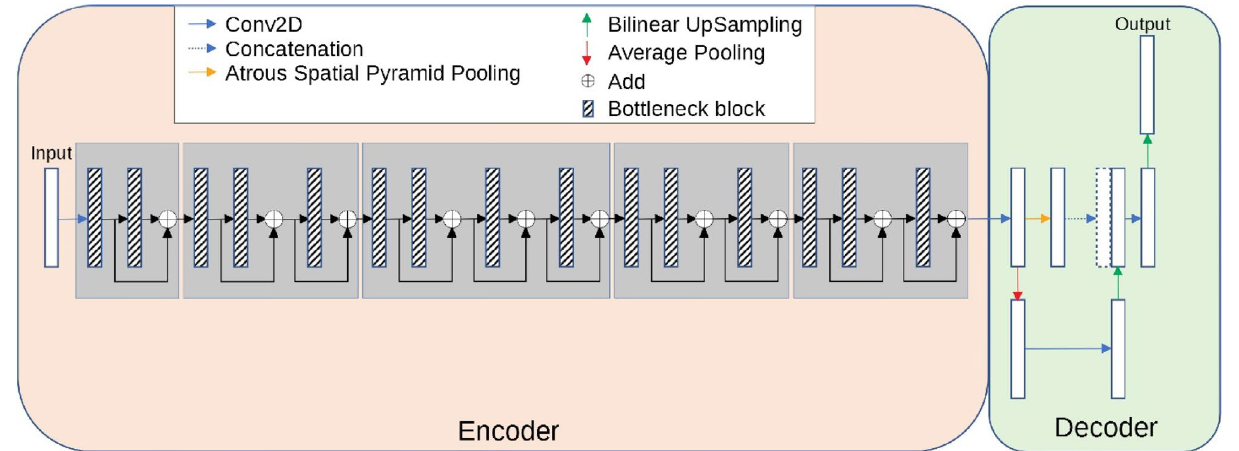
Figure 2. The encoder–decoder architecture of MobilenetV2 19 .